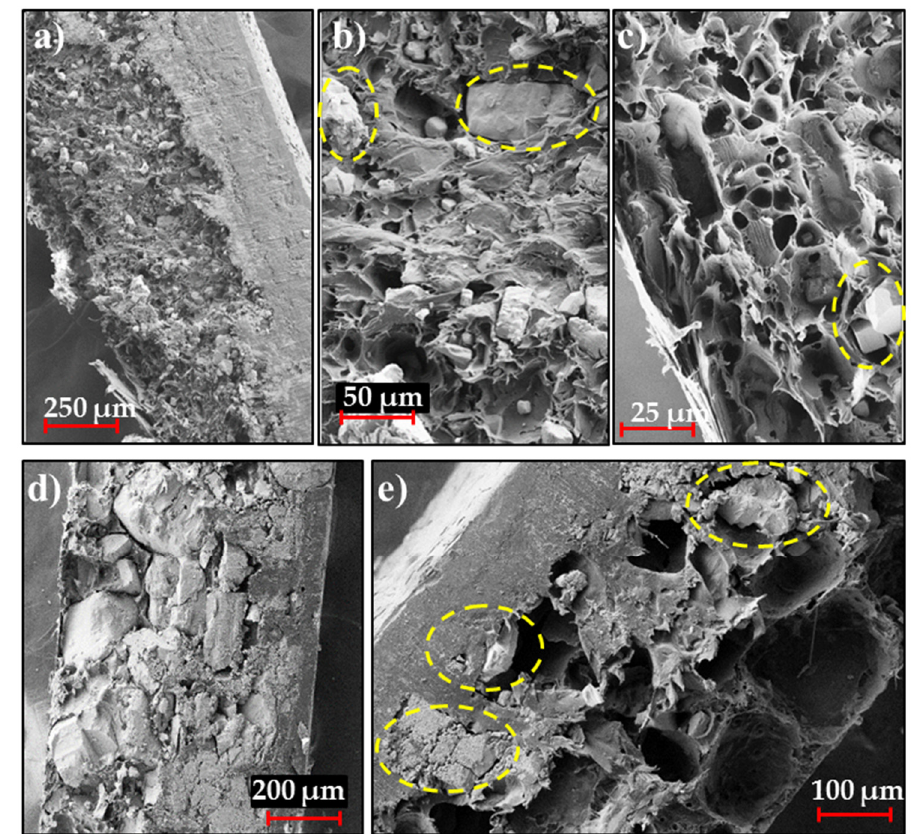
Figure 4. SEM micrographs of the cross section of PLA specimens loaded with 40 wt-% of NaCl before (( a ) for <45 µm and ( d ) for 100–250 µm) and after immersion in water (( b ) and ( c ) for <45 µm and ( e ) for 100–250 µm). NaCl particles are marked with yellow ellipsoids.